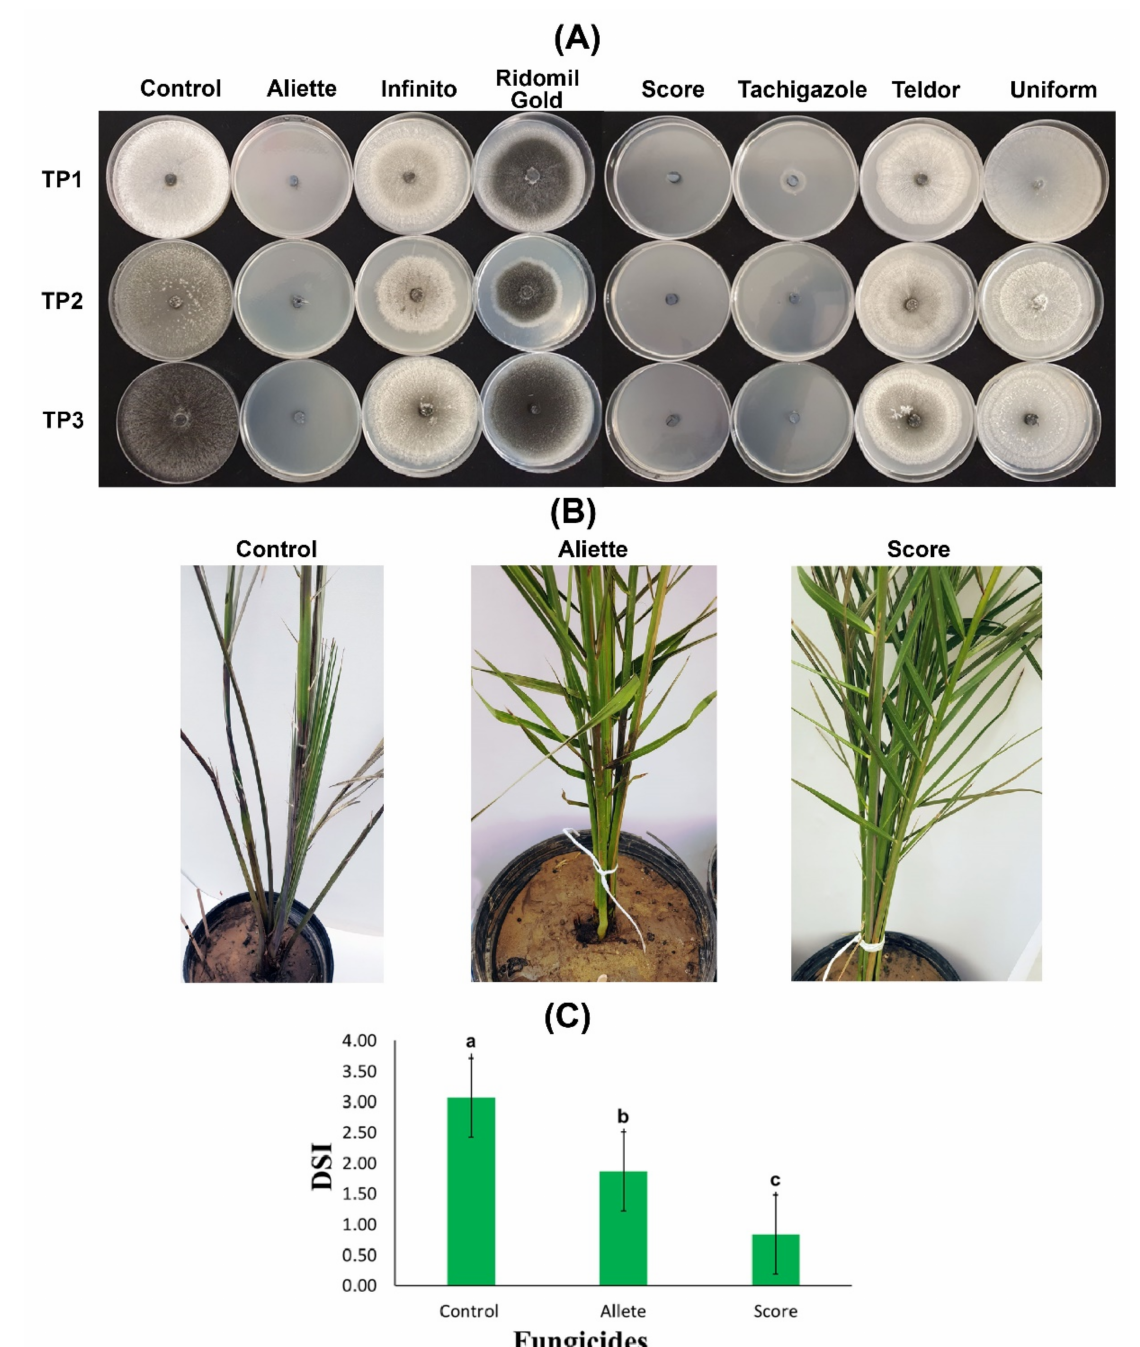
Figure 4. In vitro and in vivo evaluation of fungicides against Thielaviopsis punctulata . ( A ) Percent- age growth inhibition of mycelium from eight fungicides: Aliette, Infinito, Ridomil Gold, Score, Tachigazole, Teldor, and Uniform. The efficiency of each fungicide was tested on potato dextrose agar (PDA) media against three T. punctulata isolates: TP1, TP2, and TP3. ( B ) Date palm plants of the Khalas cultivar were first inoculated with the T. punctulata isolate TP2, and at 2 WPI, the plants were treated with the fungicides Aliette and Score. The healthy control was mock-inoculated using double distilled water. ( C ) Disease severity index (DSI) of the infected date palm plants at 8 WPI treated with the Aliette and Score fungicides. The significant values at p > 0.05 are shown as different lowercase